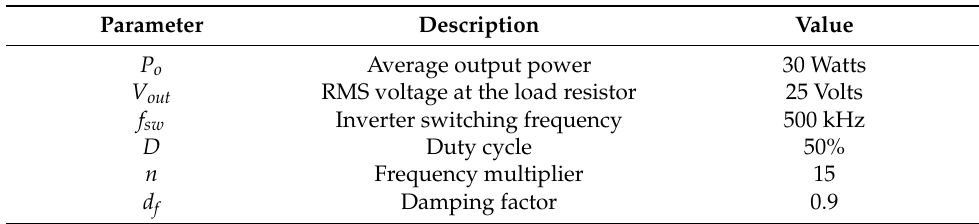
Table 1. Circuit design parameters.